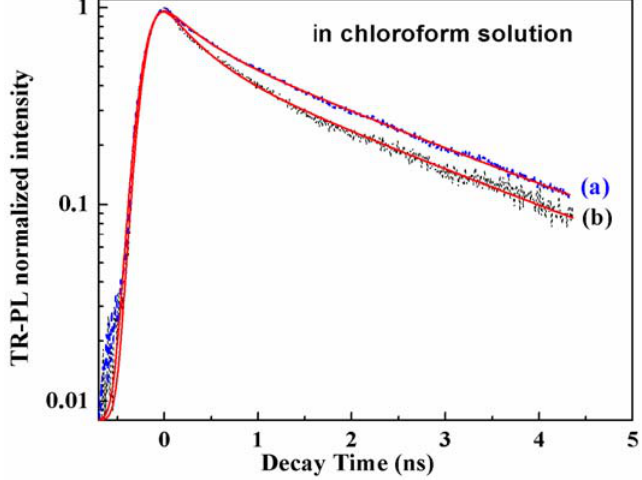
Figure 11. Integrated TR-PL decays of (a) OMPA and (b) OBMPA in chloroform solution.